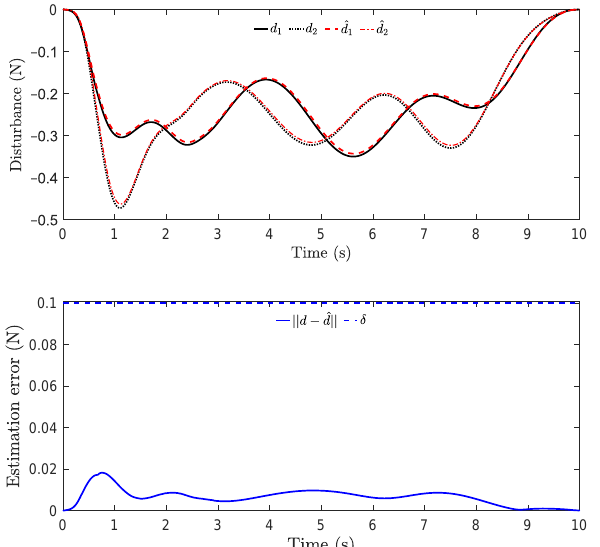
Figure 8. Actual and estimated disturbances (top) and the estimation error (bottom). Note that d i and ˆ d i ( i = 1,2) represent the i th element of d (actual disturbance) and ˆ d (estimated disturbance), respectively. The blue dashed line in the bottom plot denotes the EEB used in computing the control